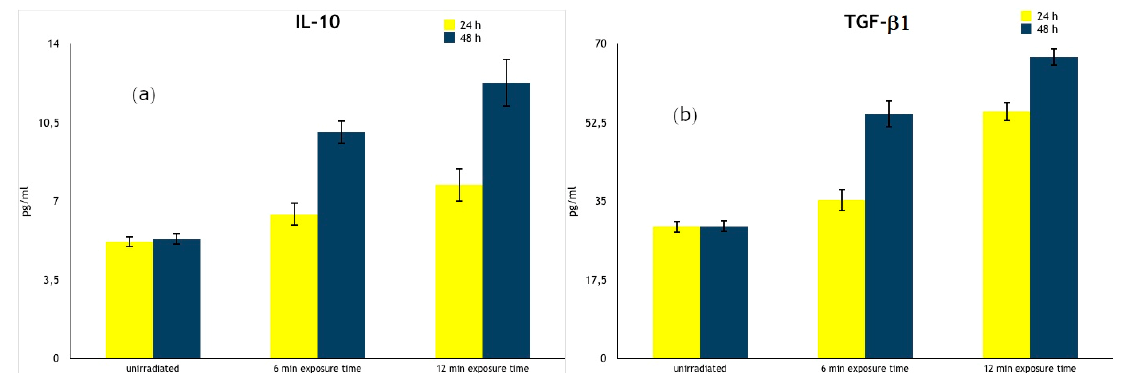
Figure 4. Anti-inflammatory cytokine production by PILER exposed and cultured human PBMCs. The results are expressed as the means of cytokine levels ± SD of 20 healthy volunteers and are expressed as pg/mL. (a) IL-10; ( b ) TGF- β 1.